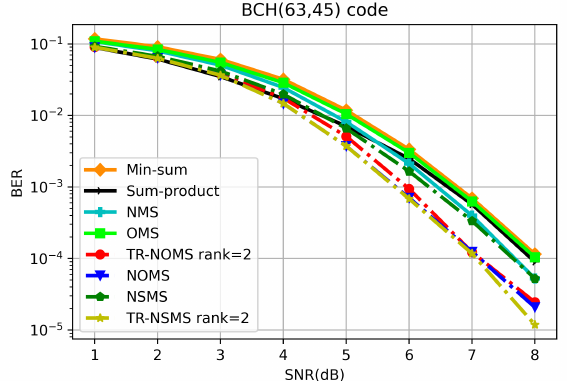
Figure 8. BER performance of TR-NOMS, TR-NSMS, NOMS [22] and NSMS algorithms for BCH(63,45) code.